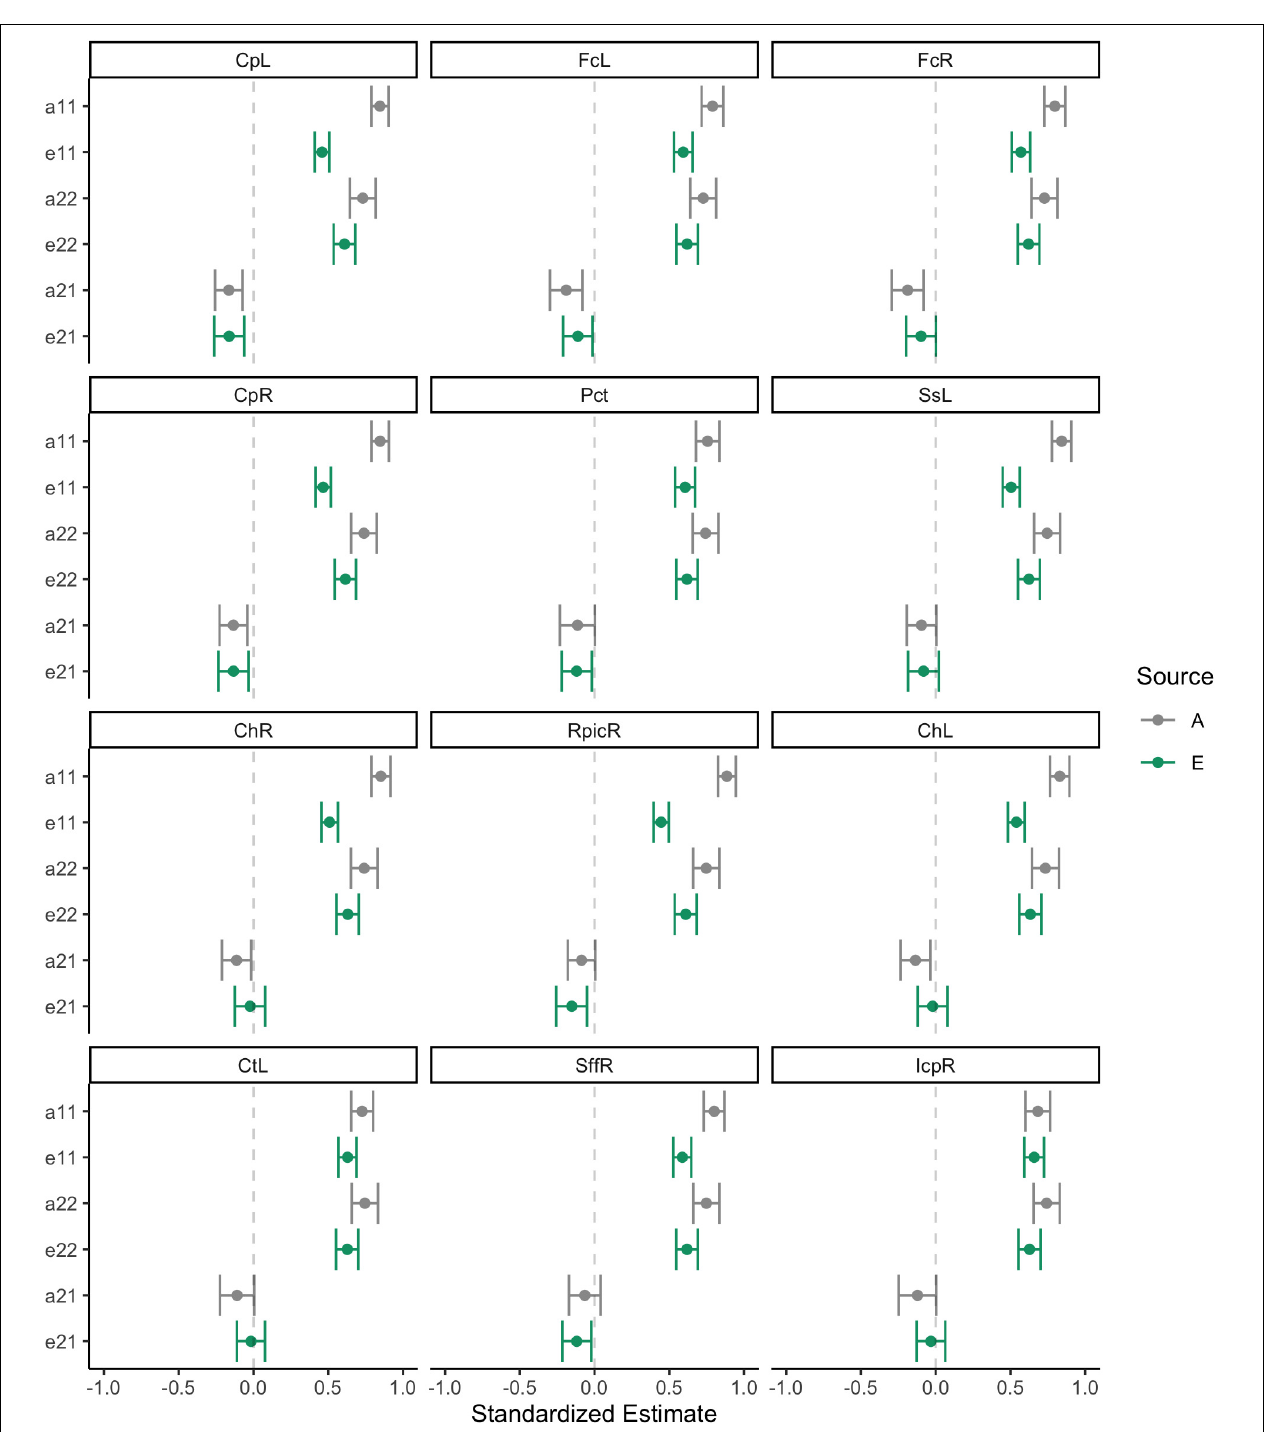
FIGURE 5 | Behavioral genetic path estimates for body mass index and white matter fractional